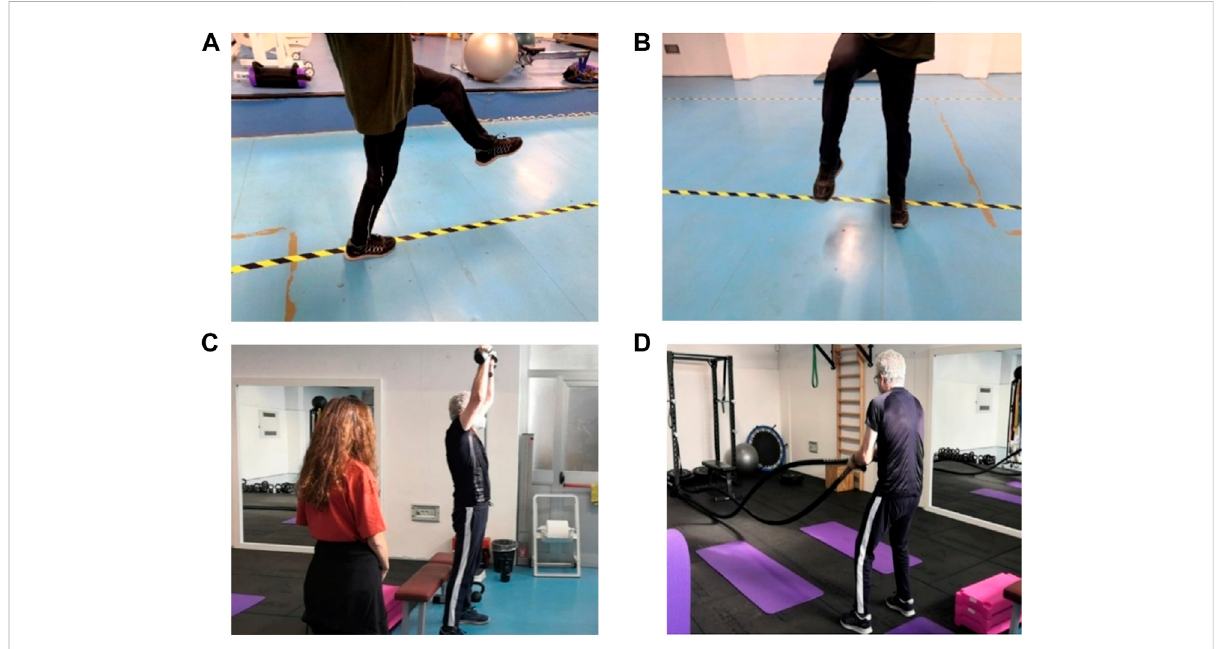
FIGURE 1 Execution of (A) frontal walk without sticks or braces; (B) side walk without sticks or braces; and (C) shoulder press with kettlebell. Next to the patient, an operator supervises the progress of the exercise; (D) alternating waves with a rope. All exercises refer to the third phase of the AMA program (with permission from the